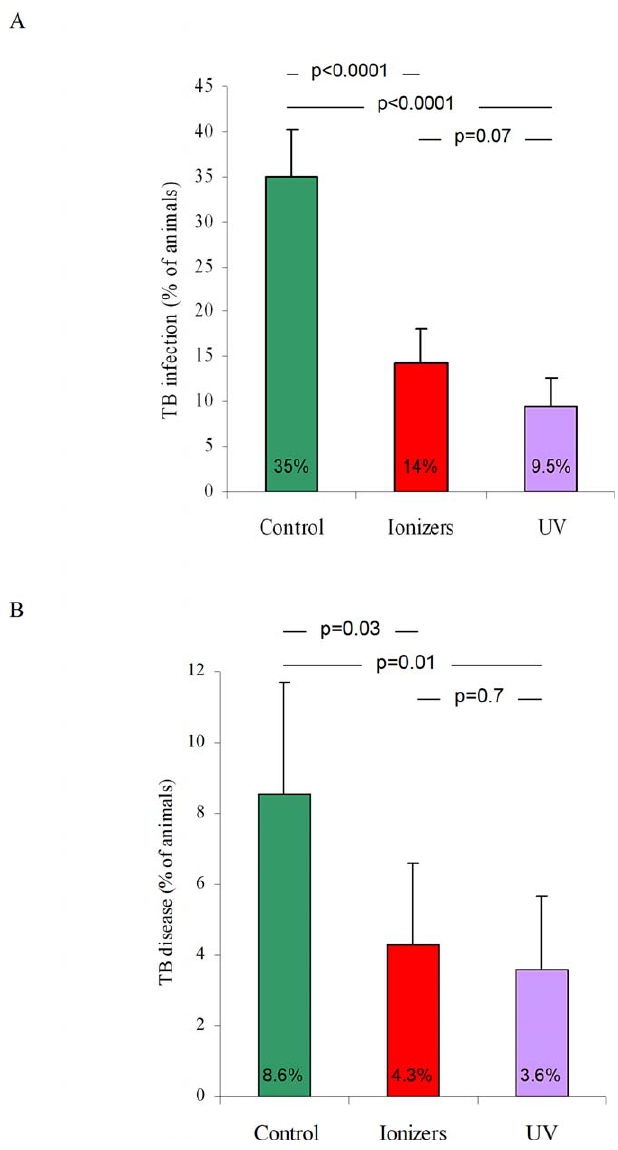
Figure 5. Proportion of Ward-Air Exposed Animals in Each Experimental Group with Evidence of TB Infection or TB Disease (A) TB infection (PPD skin test conversions). (B) TB disease (autopsy or culture evidence of